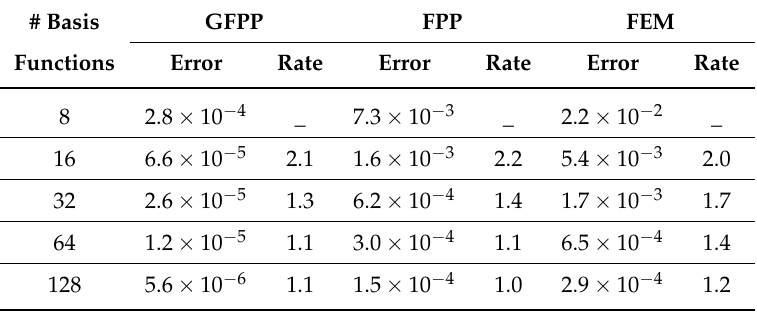
Table 2. The error estimation and convergence rate of numerical solutions to the analytic solution in Example